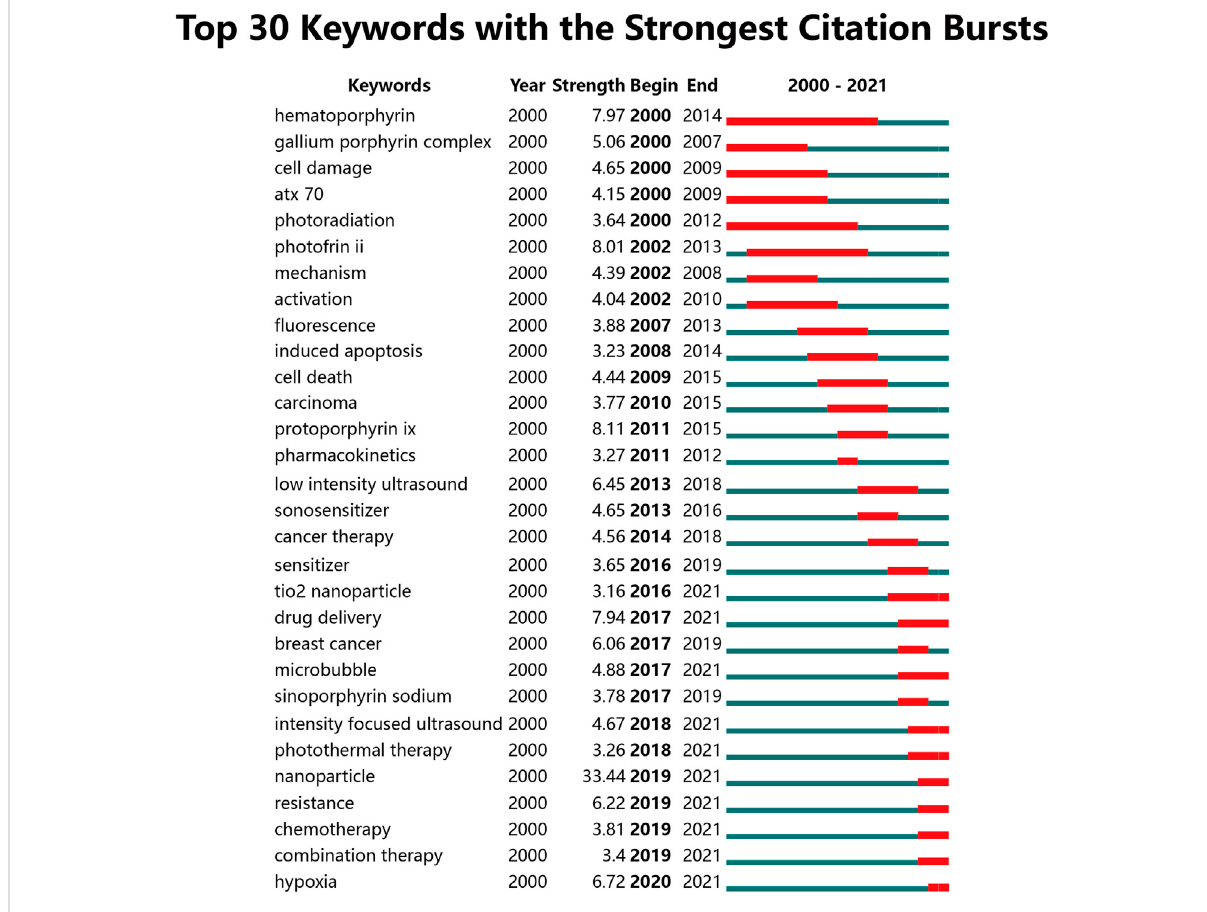
FIGURE 7 Top30keywordswiththestrongestcitationsburstsbyCiteSpace.Theredbarsrepresentedthestartingandending,andthedurationofcitation